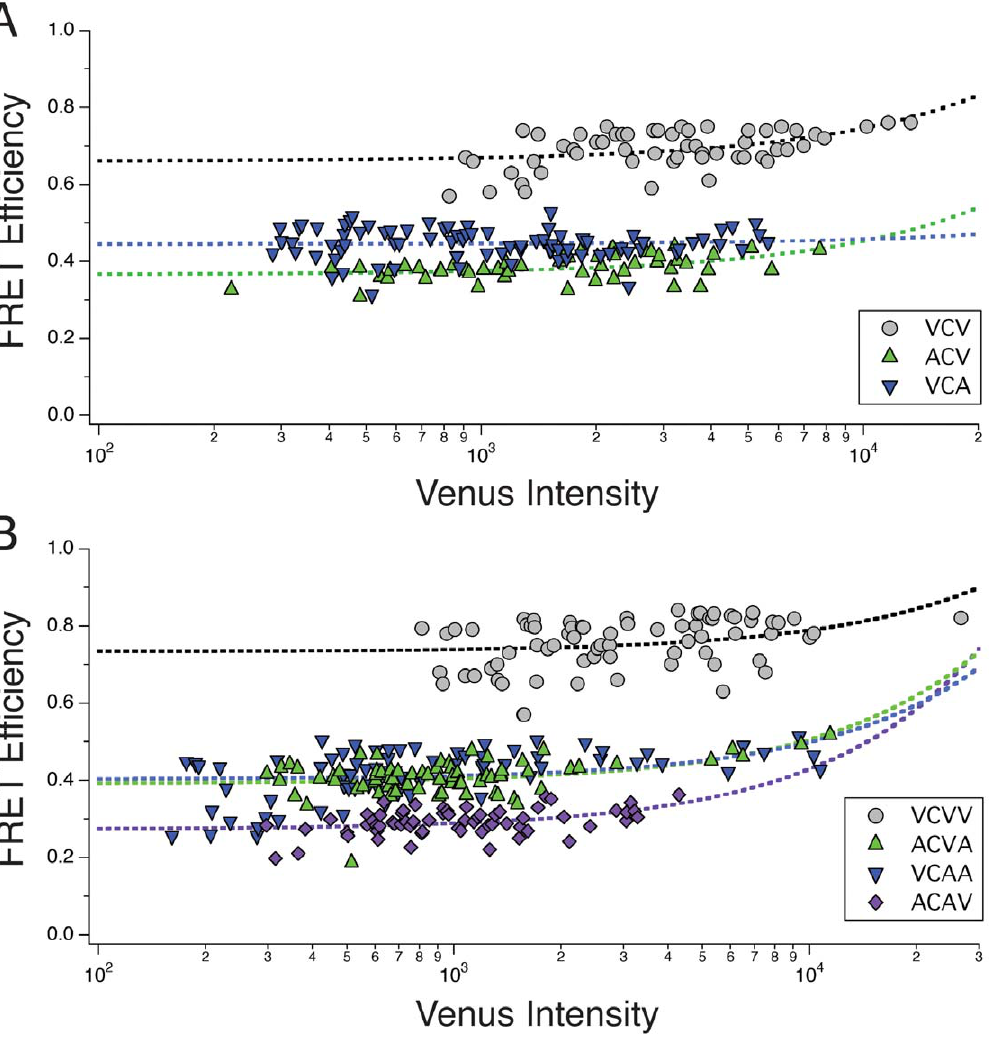
Figure 4. Estimating the intramolecular FRET efficiency. E-FRET was used to measure the FRET efficiencies and the acceptor intensity (Venus) for each cell expressing members of the VCV series (A; VCV, ACV, and VCA) or the VCVV series (B; VCVV, ACVA, VCAA, ACAV), and these values are plotted as a function of the exposure normalized Venus intensity. Dashed lines indicates linear regression fitting for each data set to calculate the y- intercept as an estimate of the amount of intramolecular FRET in the absence of intermolecular FRET. Note that the data is plotted on a semi-log scale to more easily reveal the full range of the Venus intensity, but in so doing make linear plots appear curved.